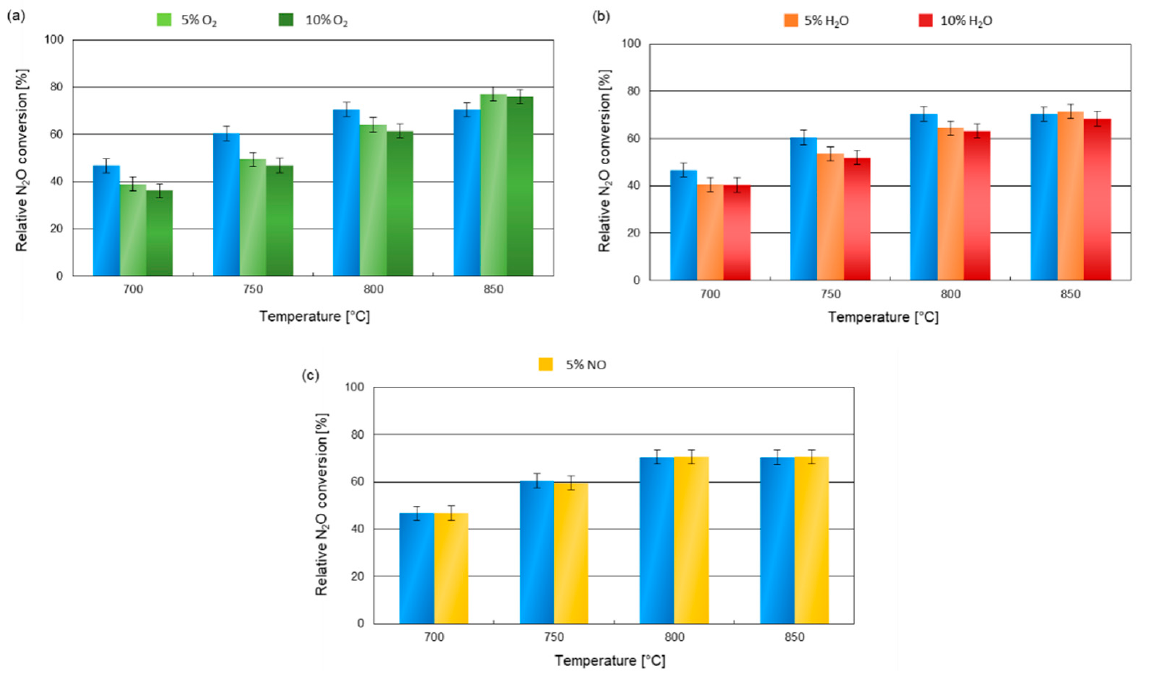
Figure 6. Nitrous oxide conversions in streams with different compositions: ( a ) 5 and 10 % O 2 concentration, 5% N 2 O, Ar ( b ) 5 and 10% water vapor content, 5% N 2 O, Ar and ( c ) 5% N 2 O, Ar with and without 5% NO in the stream.